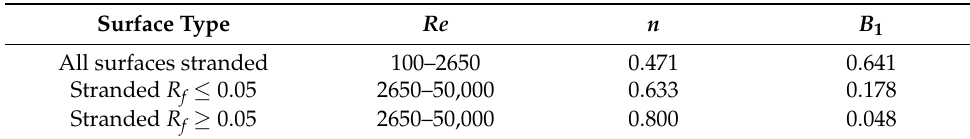
Table 1. Values of constants n and B 1 [7].